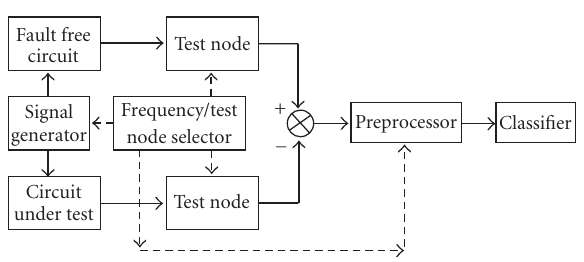
Figure 2: Block diagram of the proposed multiple fault diagnosis.